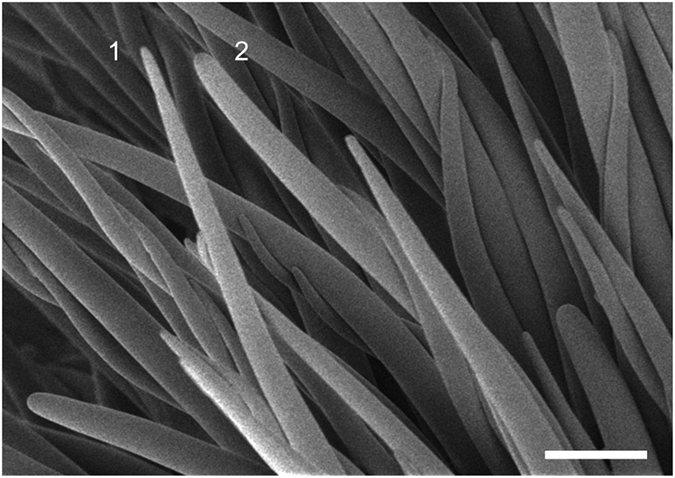
Early elongating fibers of G. hirsutum have different tip morphologies as observed by cryo-field emission scanning electron microscopy (cryo-FE-SEM).At 2 DPA, a mixed population of fibers with narrow, pointed tips (fiber 1) or wide, rounded tips (fiber 2) was observed. Different tip morphologies occurred on fibers of similar length. Scale bar = 50 μm.